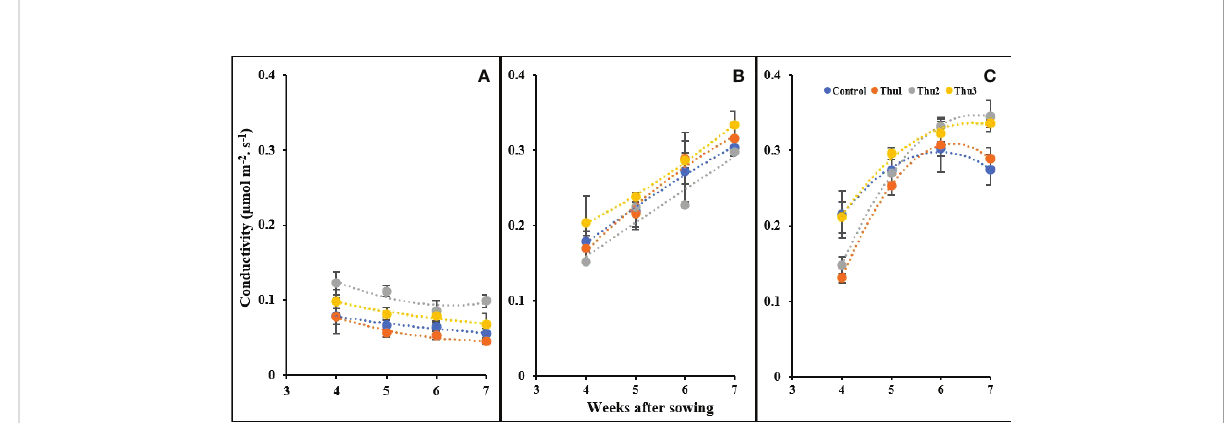
FIGURE 13 Changes in stomatal conductivity under application of Th17 at low (A) , optimum (B) and high (C) temperature at 4, 5, 6 and 7 weeks after sowing. Thu1: 10 -7 M Th17, Thu2: 10 -9 M Th17, Thu3: 10 -11 M Th17. Each point represents mean ± standard error (n=8).